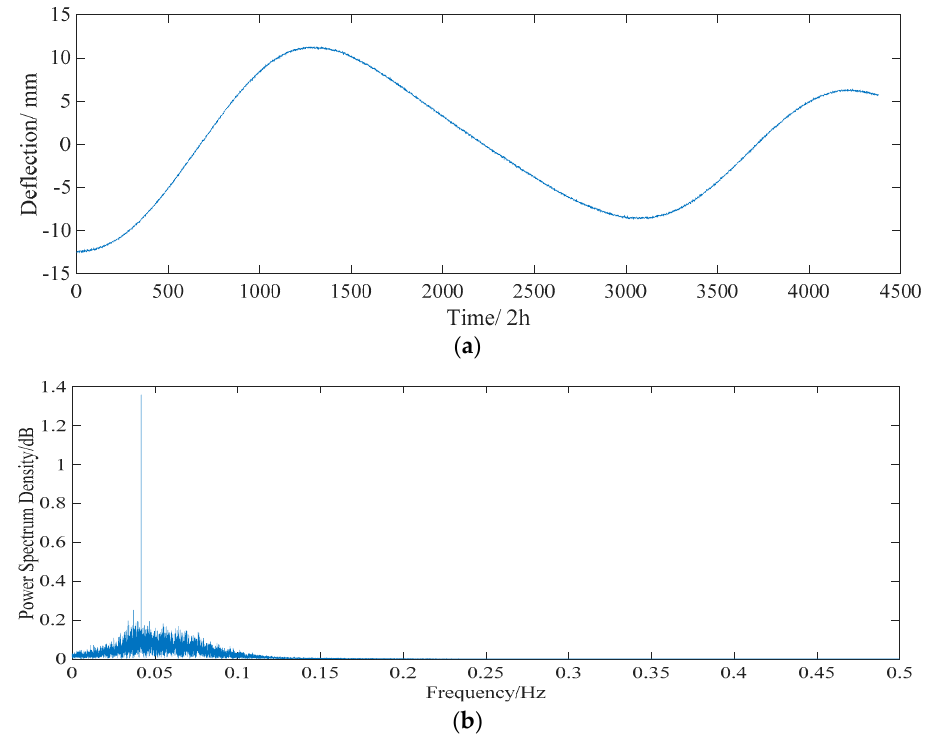
Sensors 2018 , 18 , x FOR PEER REVIEW Figure 17. Separated daily temperature deflection effect. ( a ) Time history data. ( b ) Power spectrogram.